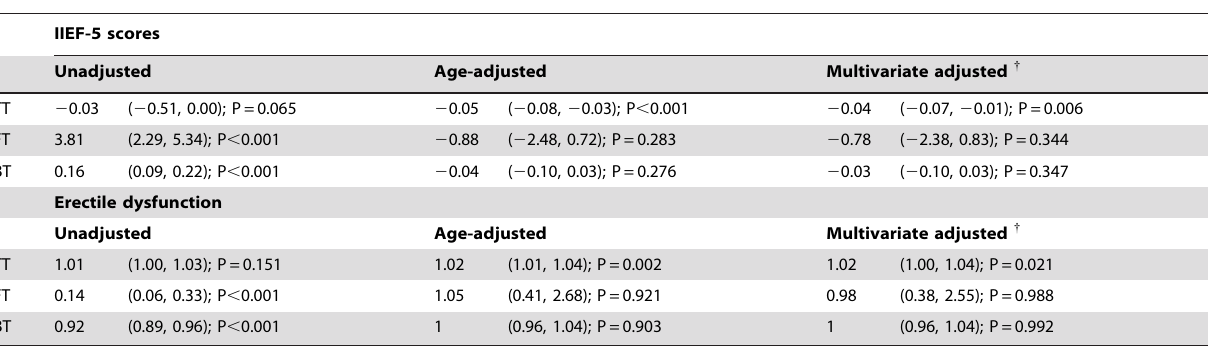
Table 2. Association between testosterone and ED in the multivariate regression analysis {